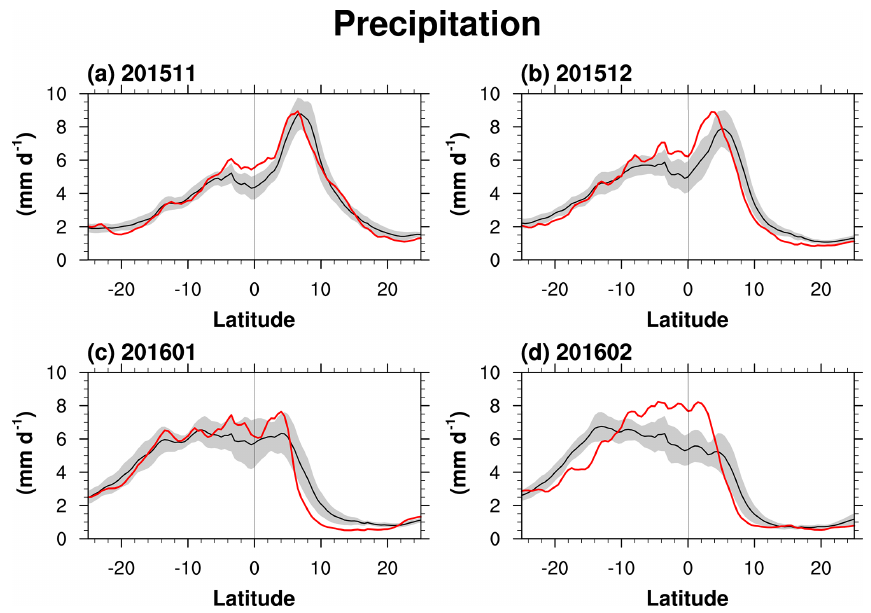
Figure 9. Zonal mean precipitation from MERRA-2 in (a) November 2015, (b) December 2015, (c) January 2016, and (d) February 2016 (red) and their monthly climatology (black) with ± 1SD (gray